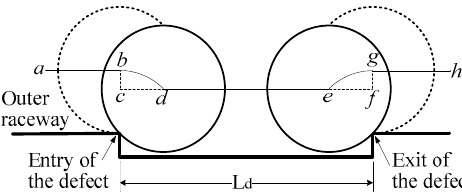
Figure 2. The rolling path of centre of the ball from entry to the exit of the spall.